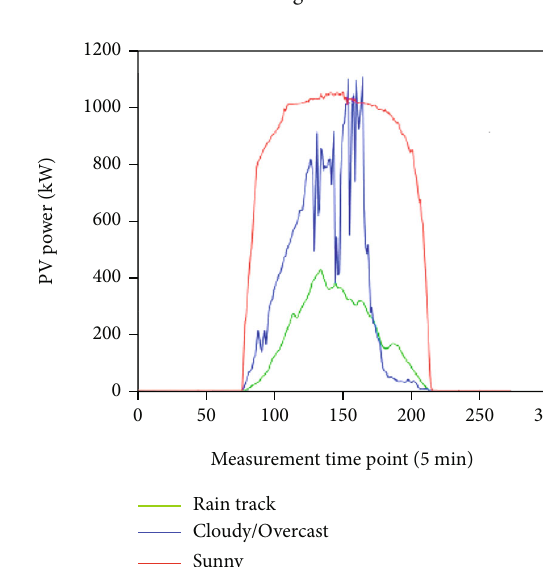
Figure 12: Comparison of output power under various climate